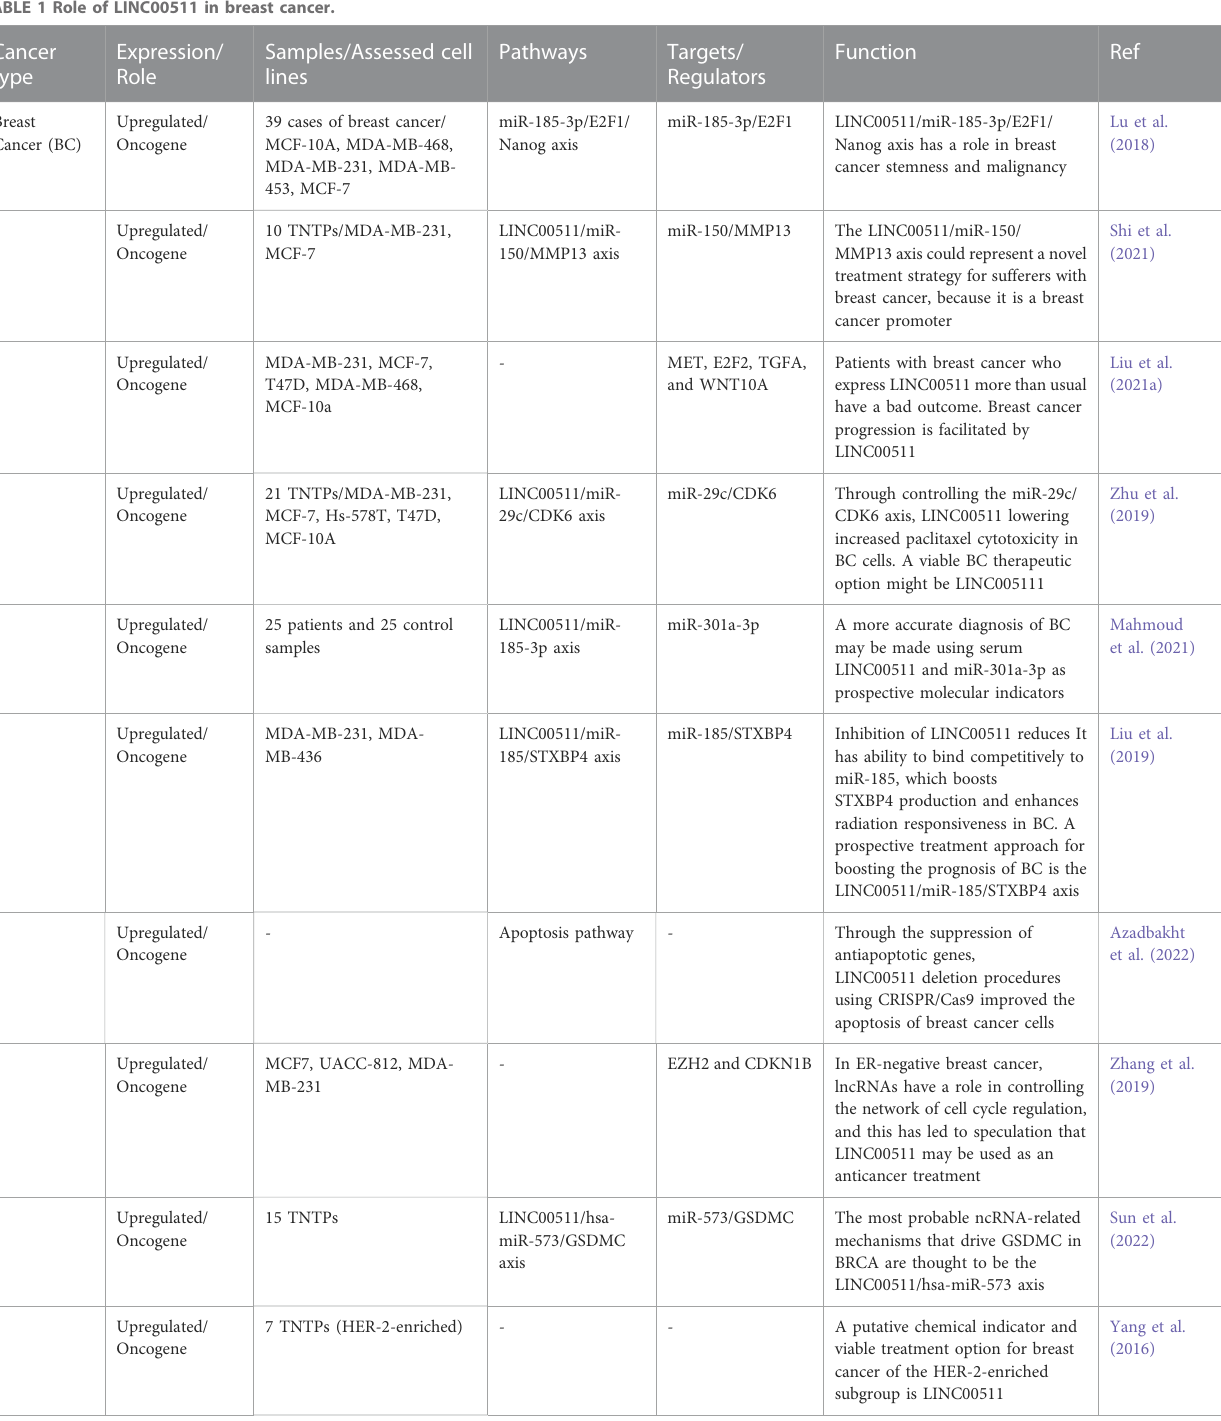
TABLE 1 Role of LINC00511 in breast